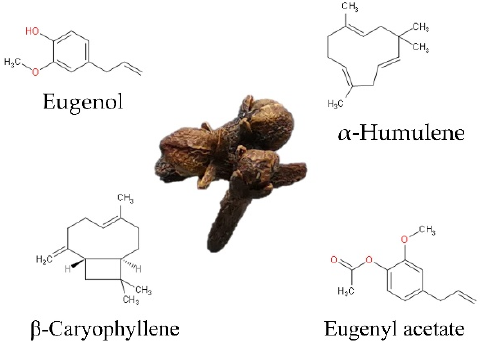
Figure 1. Chemical structure of main compounds of clove ( S. aromaticum L.) essential oil. Table 1. Comparison of chemical composition (%) of CEO reported by different authors. González-Rivera, J., et al. Golmakani, M. T., et al. 2017 [19] Kennouche, A., et al. 2015 [21]